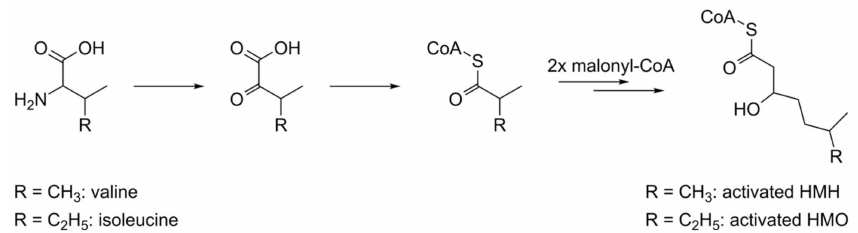
Figure 6. Proposed biosynthesis of HMH and HMO.